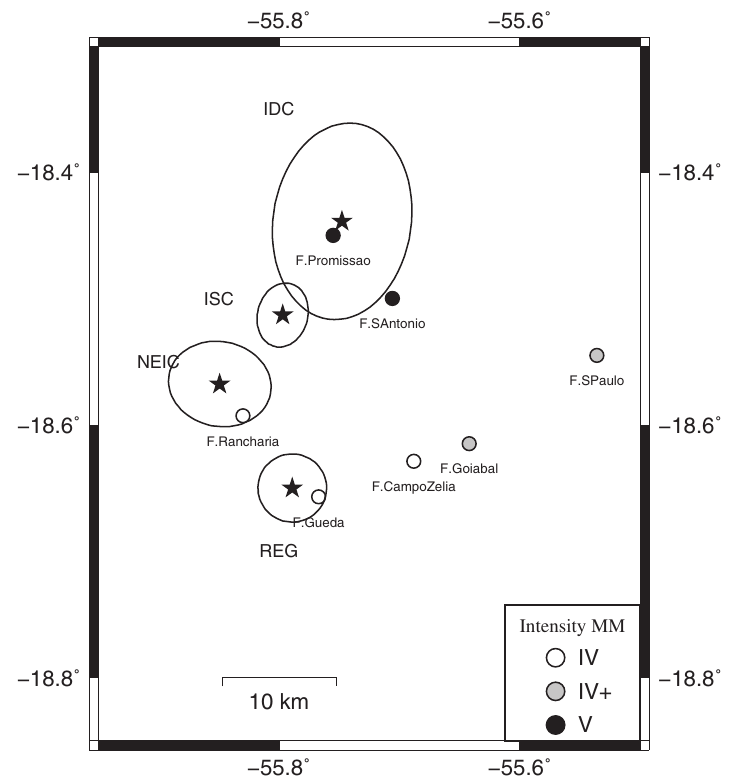
Figure 3 - Macrosseimic survey in the epicentral area. The maximum intensity was MM V near Promissão and Santo Antônio farms. The epicenters of different international agencies (ISC, IDC, USGS/NEIC) and this paper (REG) are represented by the stars, with ellipses showing their 95% confidence